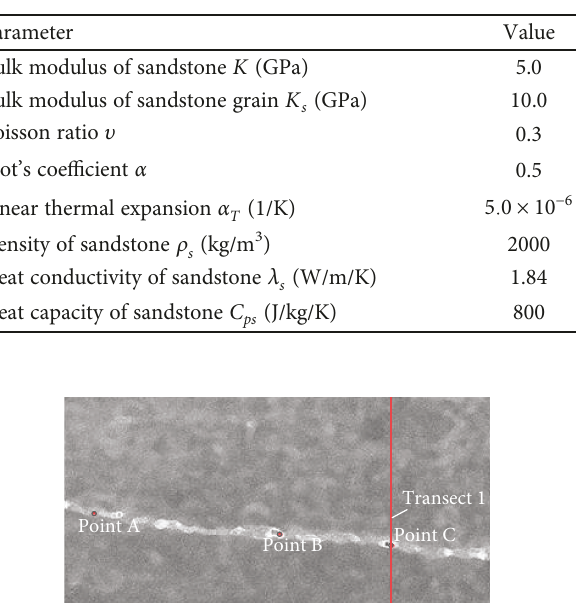
Table 5: Simulation matrix. Table 4: Properties and parameters used for the simulation model.